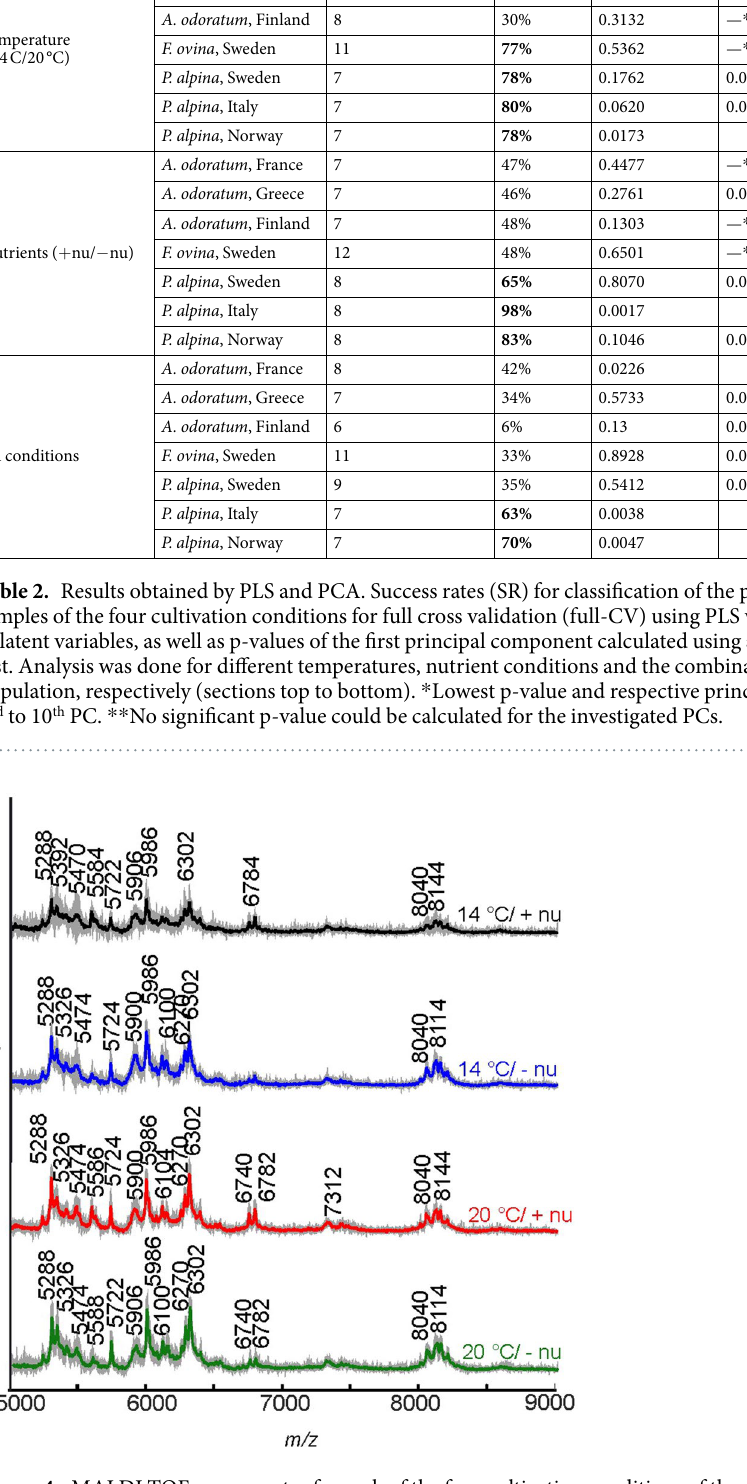
Figure 4. MALDI TOF mass spectra for each of the four cultivation conditions of the plants producing the pollen for the Italian population of P. alpina . All four spectra are averages of 10 individual spectra from 10 individual plants; the grey shading indicates the standard deviation. Abbreviations: + nu, additional nutrients, − nu, no additional